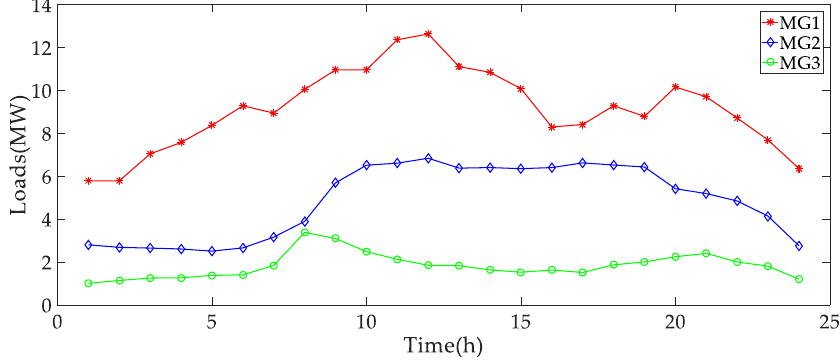
Figure 2. Power loads for MGs.